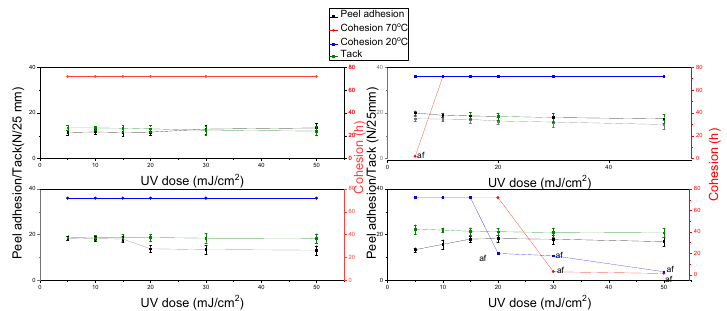
Figure 5. Results of cohesion at 20 °C and 70 °C, peel adhesion, and tack for self-adhesive tapes obtained from acrylate copolymers from P1 synthesis. The results for self-adhesive tapes obtained from acrylate copolymers from P2 syn- thesis are shown in Figure 6. Cohesion at the temperatures of 20 °C and 70 °C showed low values, which are unacceptable in the technology of pressure-sensitive adhesives. Only for the basis weight of 30 g/m 2 and the radiation dose of 50 mJ/cm 2 , the higher cohesion at a temperature of 20 °C can be observed. Tack and peel adhesion showed high values, but a cohesive failure was observed during the test. This may be due to the lack of cross-link- ing of tapes made predominantly of an acrylate copolymer based on 2-ethylhexyl acrylate.